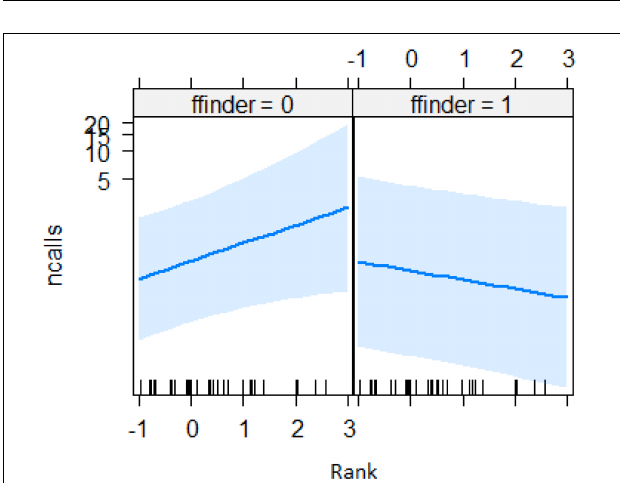
FIGURE 5 | Effect of caller’s rank when being the first to find the snake ( Y -axis in log scale). Rank data has also been transformed so it could be better